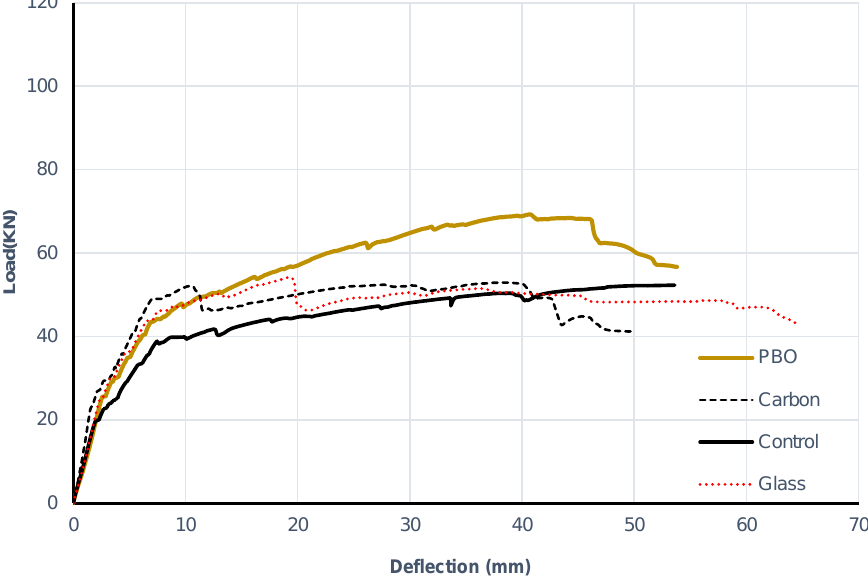
Figure 10. Load-deflection curves for Group I beams.